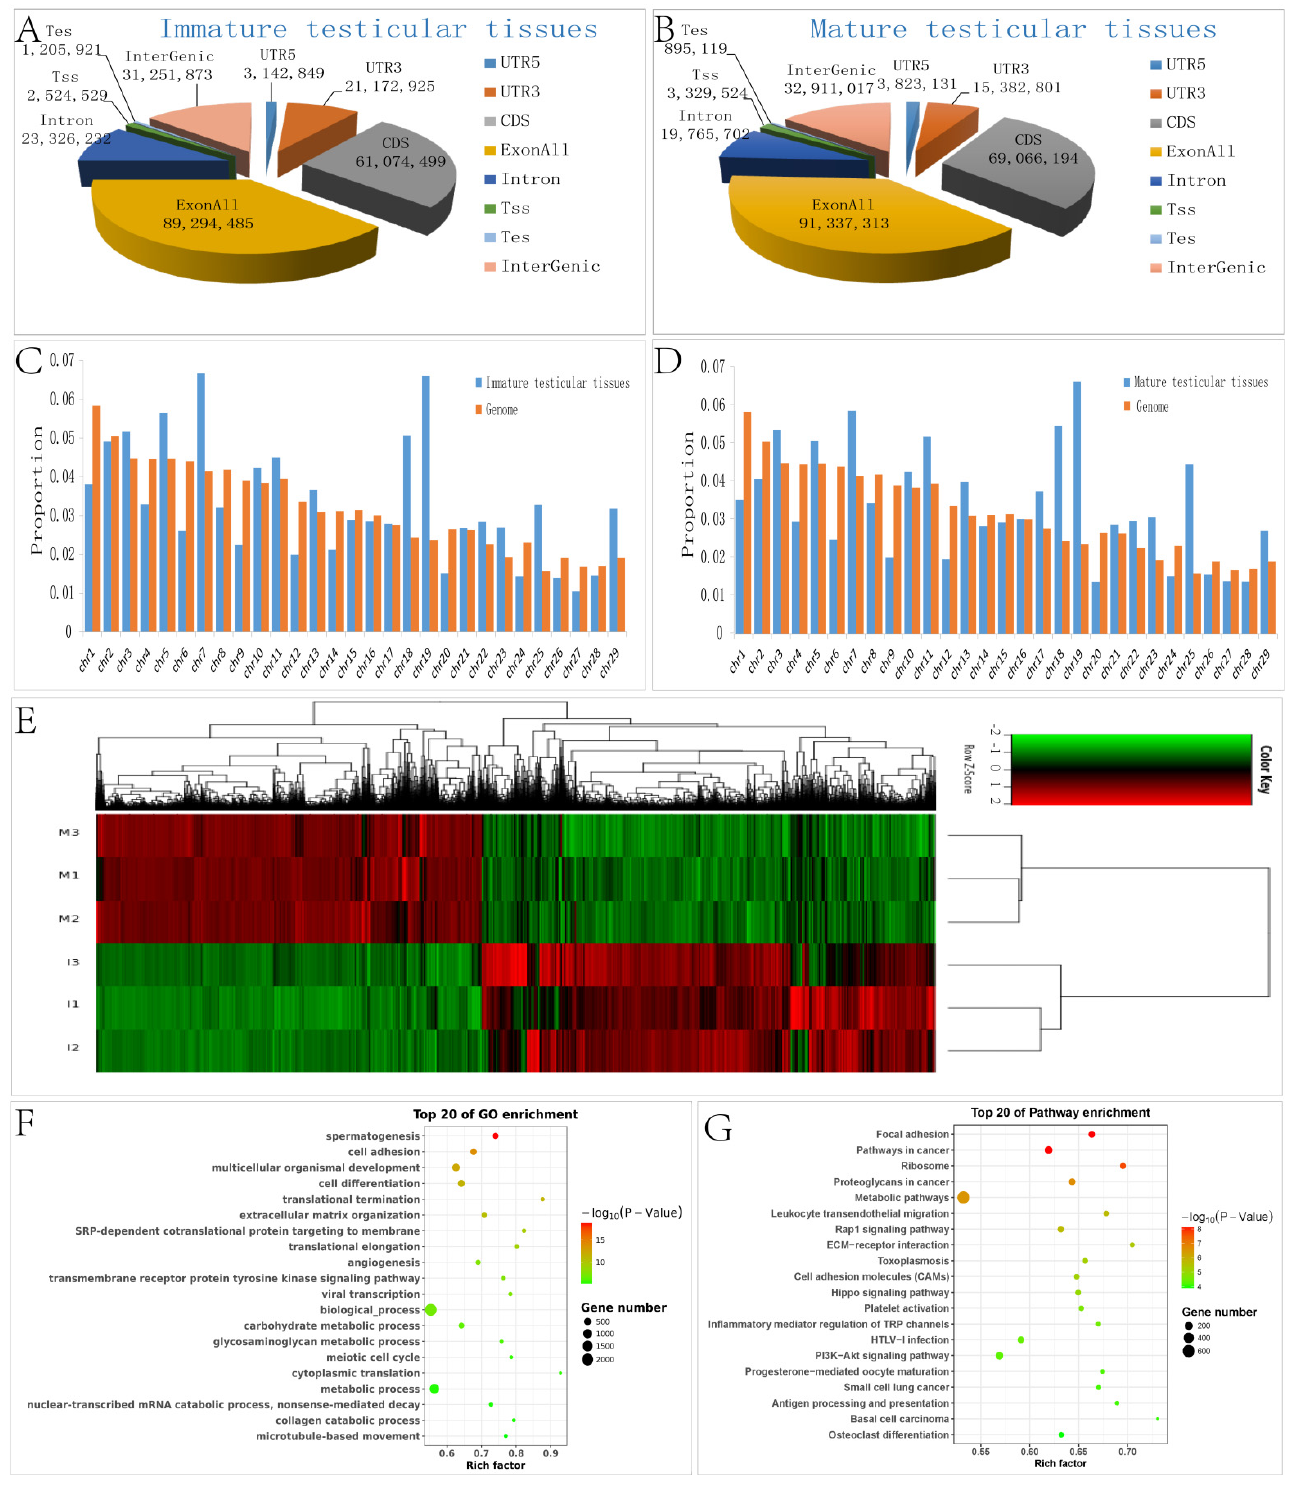
Figure 1. Analysis of RNA-seq data and differentially expressed genes. ( A , B ) Functional genomic elements distribution of mRNA reads in immature testicular tissue and mature testicular tissue, each part of the pie chart representing the number of average reads enriched into each functional element; ( C , D ) The average distribution coverage at different chromosomes of the genome about mapped reads in immature testicular tissue and mature testicular tissue. The blue bar charts show the proportion of average distribution coverage, and the gray bar charts show the proportion of different chromosomes lengths in the genome; ( E ) Heat map of differentially expressed genes, and the color bar represent normalized FPKM values, green represents down-regulation of gene mRNA expression levels, and red represents up-regulation; ( F ) GO en- richment of differentially expressed genes; ( G ) KEGG enrichment of differentially expressed genes. Note: The ordinate